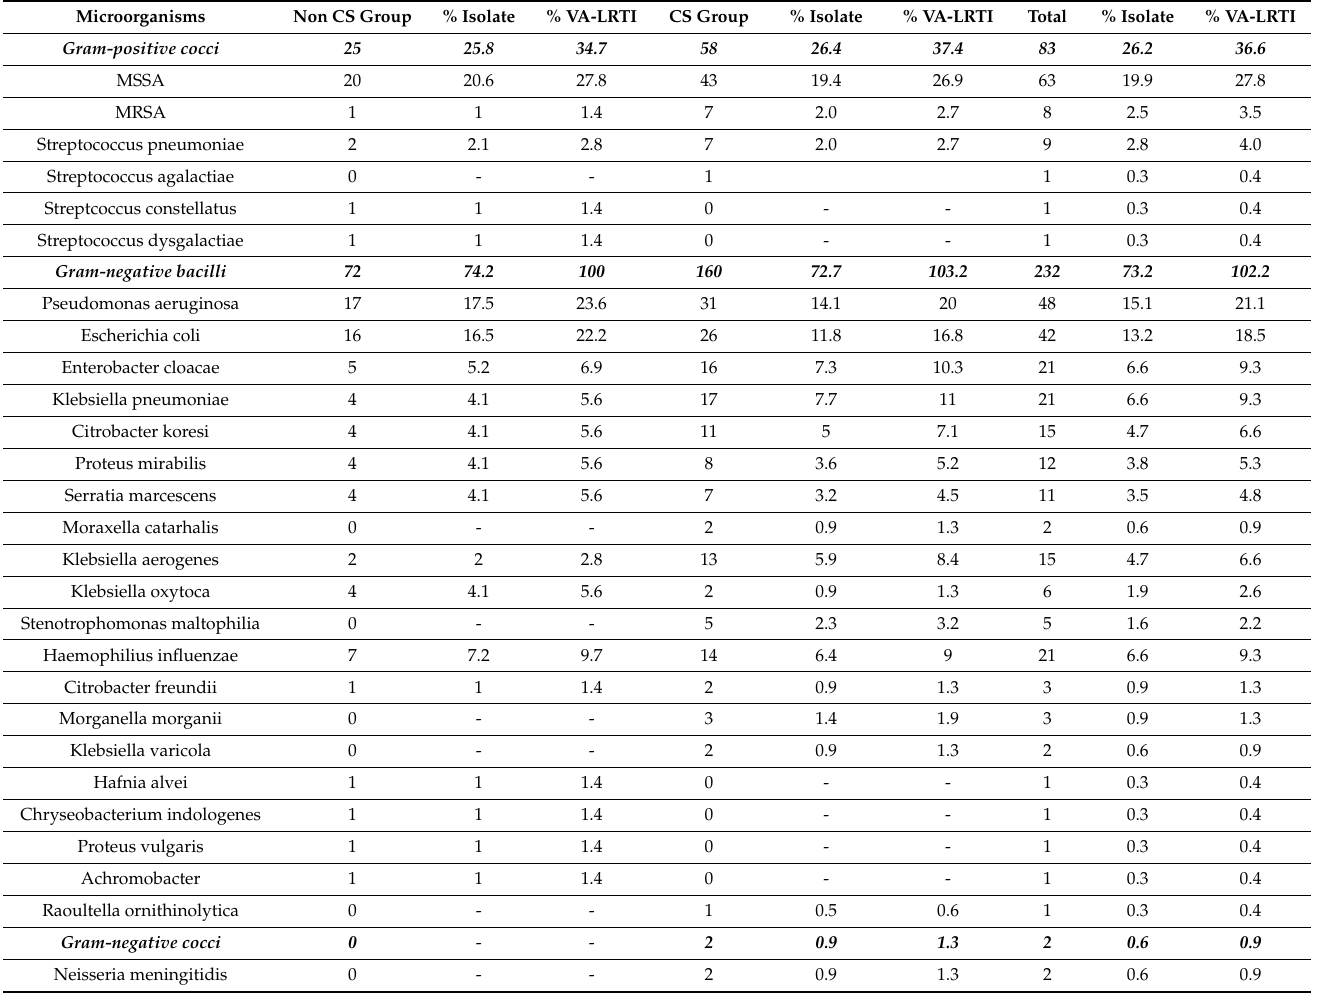
Table 4. Microorganisms responsible for ventilator-associated lower respiratory tract infection within the first 30 days of MV in the early corticosteroid group vs. non-corticosteroid